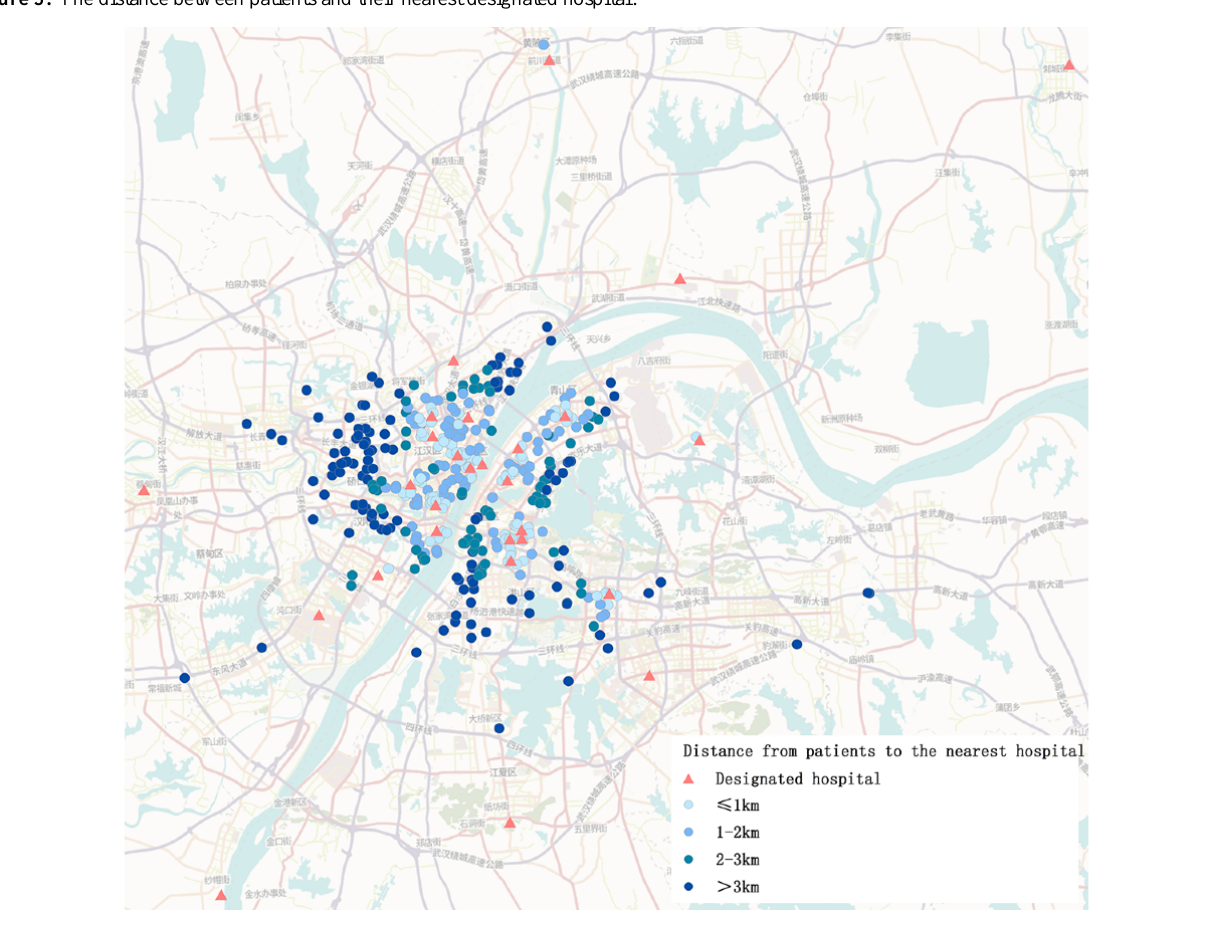
Figure 5. The distance between patients and their nearest designated